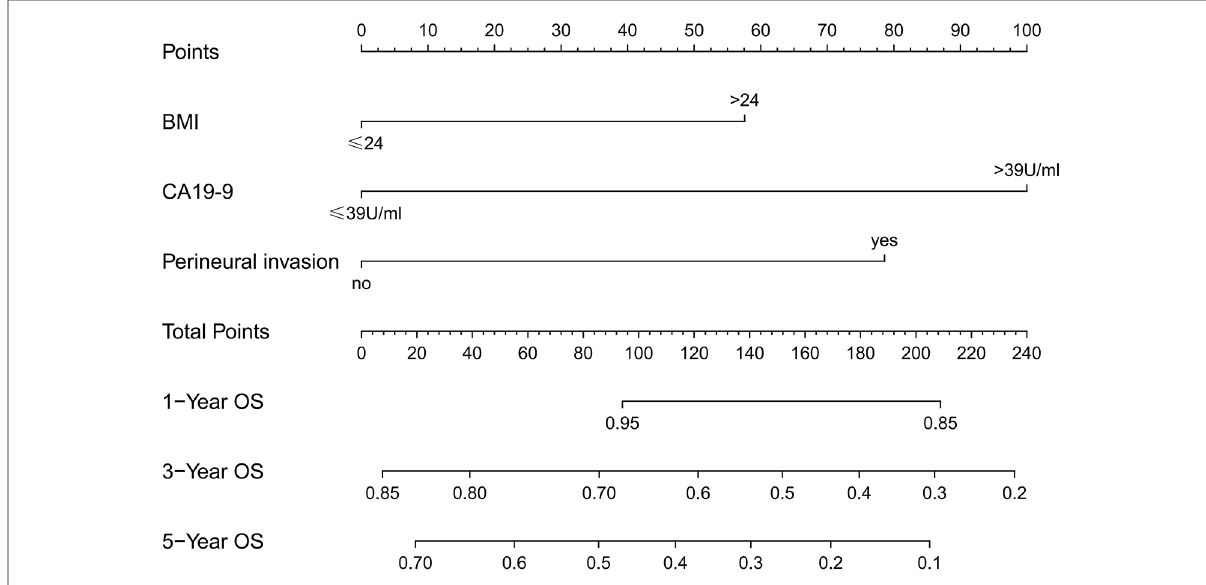
FIGURE 5 Nomogram predicting 1-, 3-, and 5-year overall survival in patients undergoing hepatectomy for CRLM.